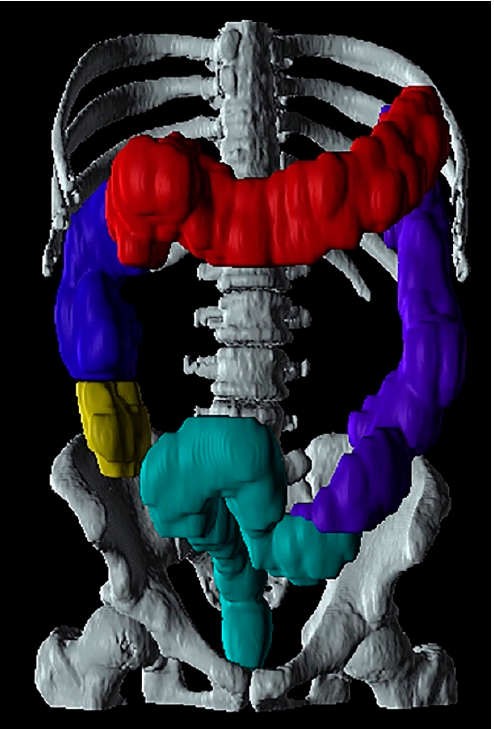
Figure 3. Example of colonic volumes from a computed tomography scan. Yellow: cecum, blue: ascending colon, red: transversal colon, purple: descending colon and turquoise: rectosigmoid colon. Used with permission from M. Klinge, Dissertation, January 2020.